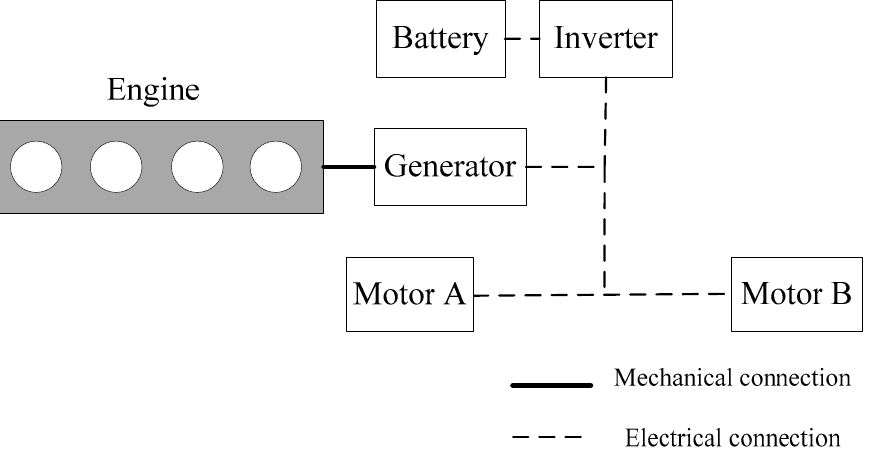
Figure 1. Structure of the series hybrid electric vehicle.